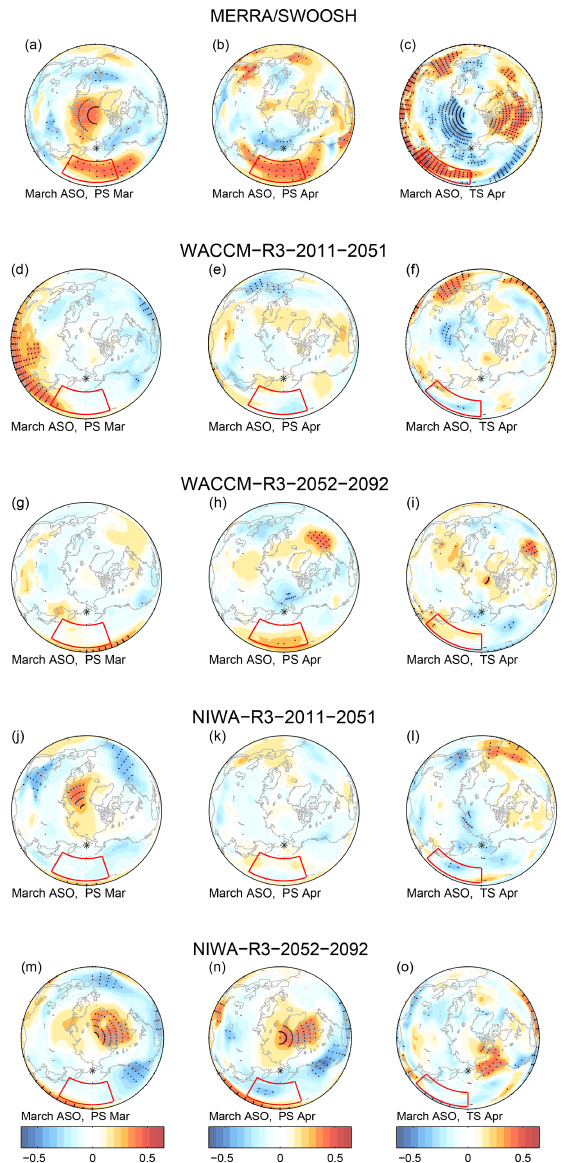
Figure 6. Correlation coefficient between ASO anomalies and surface pressure (PS) or surface temperature (TS) anomalies for MERRA/SWOOSH, WACCM-R3, and NIWA-R3, where R3 indi- cates the third realization. The left and center columns represent the correlation between ASO and surface pressure. The region of interest discussed in Sect. 4 is marked by the red frame and is de- fined by 20–50 ◦ N and 150–200 ◦ W. The leftmost column shows the correlation between March ASO and March surface pressure, and the center column shows the correlation between March ASO and April surface pressure. The rightmost column shows the correlation between the March ASO anomalies and April near-surface temper- ature. The region of interest discussed in Sect. 4 is marked by a red frame and is defined by 15–40 ◦ N and 130–180 ◦ W. In all the plots, the black dots mark the areas in which the correlation is statistically significant at the 95% level. The contour interval is 0.065.